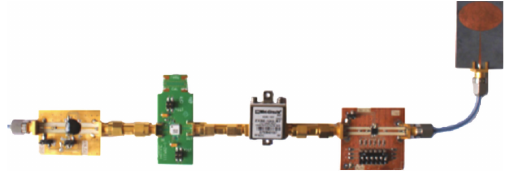
Figure 6: Hardware realization of a UWB autocorrelation receiver.